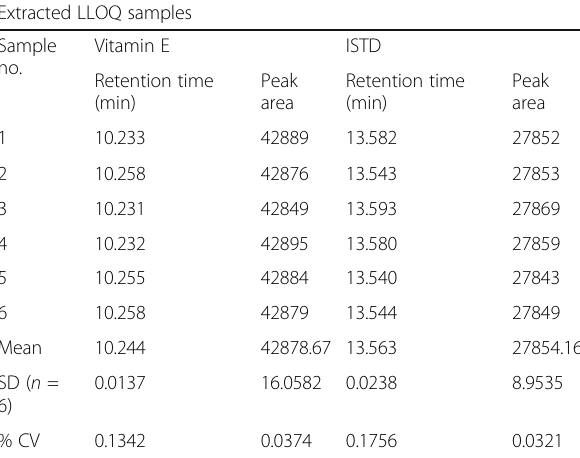
Table 3 Parameters for LLOQ samples of vitamin E Extracted LLOQ samples Sample no.